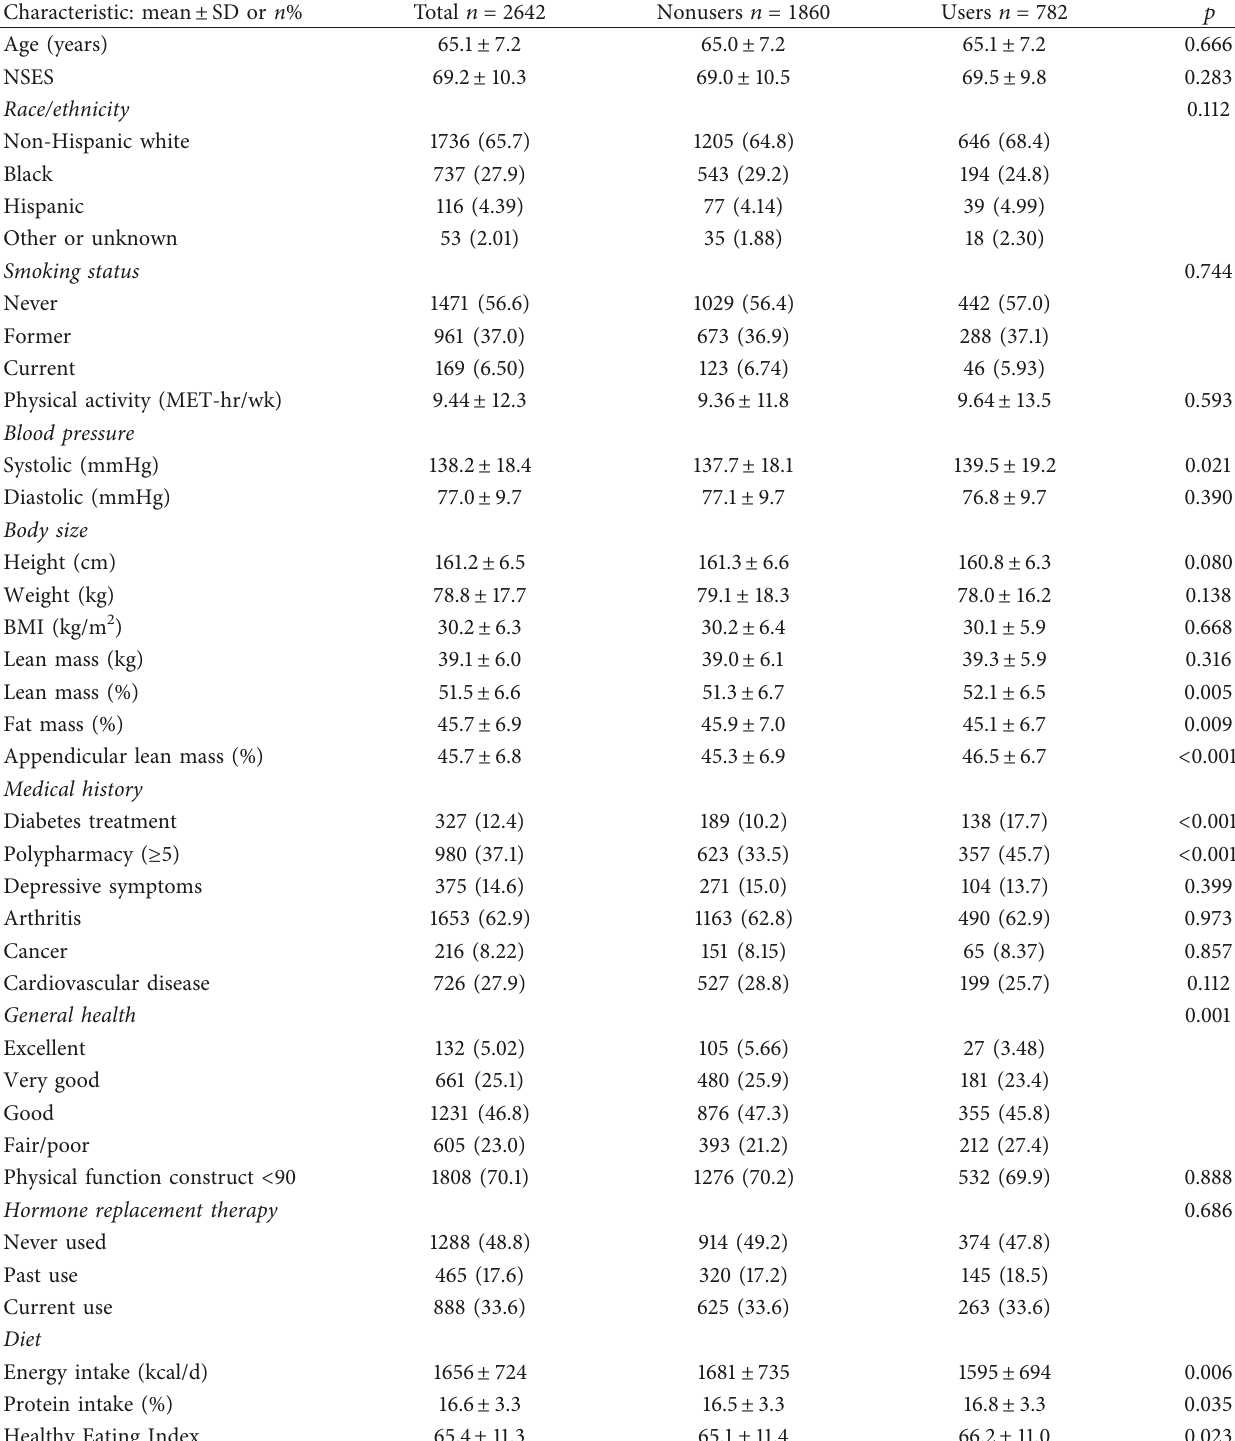
Table 1: Baseline characteristics of hypertensive women in the Women’s Health Initiative DXA Cohort by ACE-I/ARB use ∗ † . Characteristic: mean ± SD or n